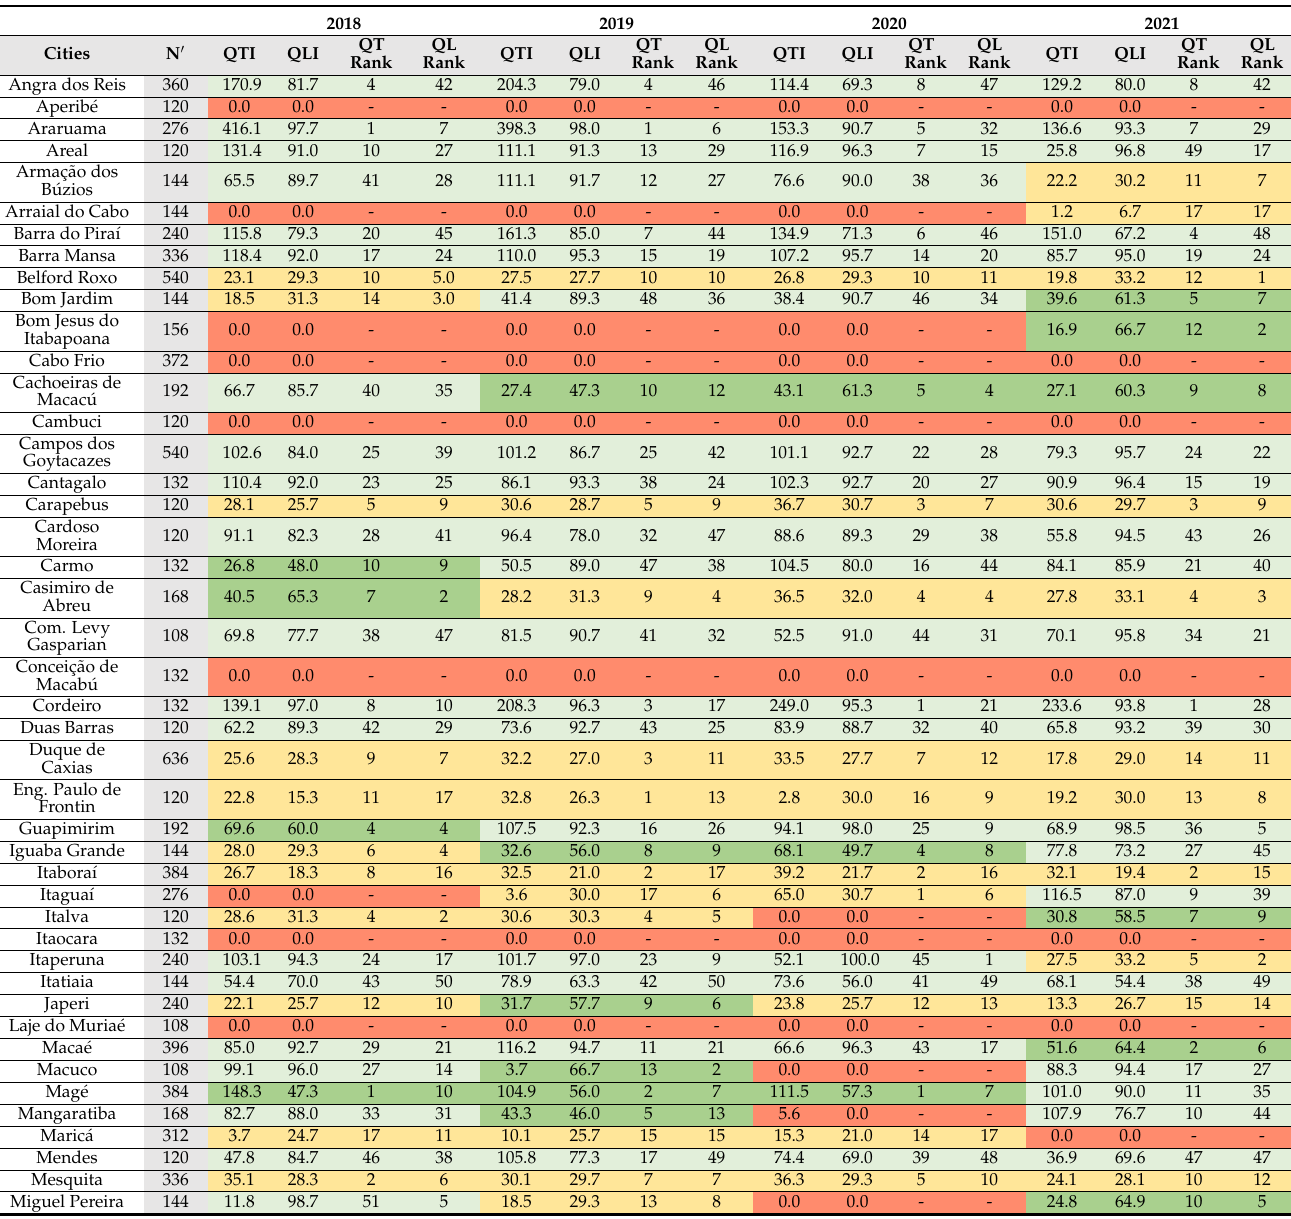
Table 1. Cities in Group A for the years of 2018 to 2021. Each year has four columns: the Quantitative Index (QTI), an arithmetic mean of the number of samples taken (N) according to that required by law (N (cid:48) ) for chlorine, turbidity, and coliforms; the Qualitative Index (QLI) samples complying with the water quality standard. The other two columns indicate the relative ranking of the SRJ cities for both aspects. Color code (light green, Group A; dark green, Group B; yellow, Group C). Cities in Group D (red) are without basic monitoring